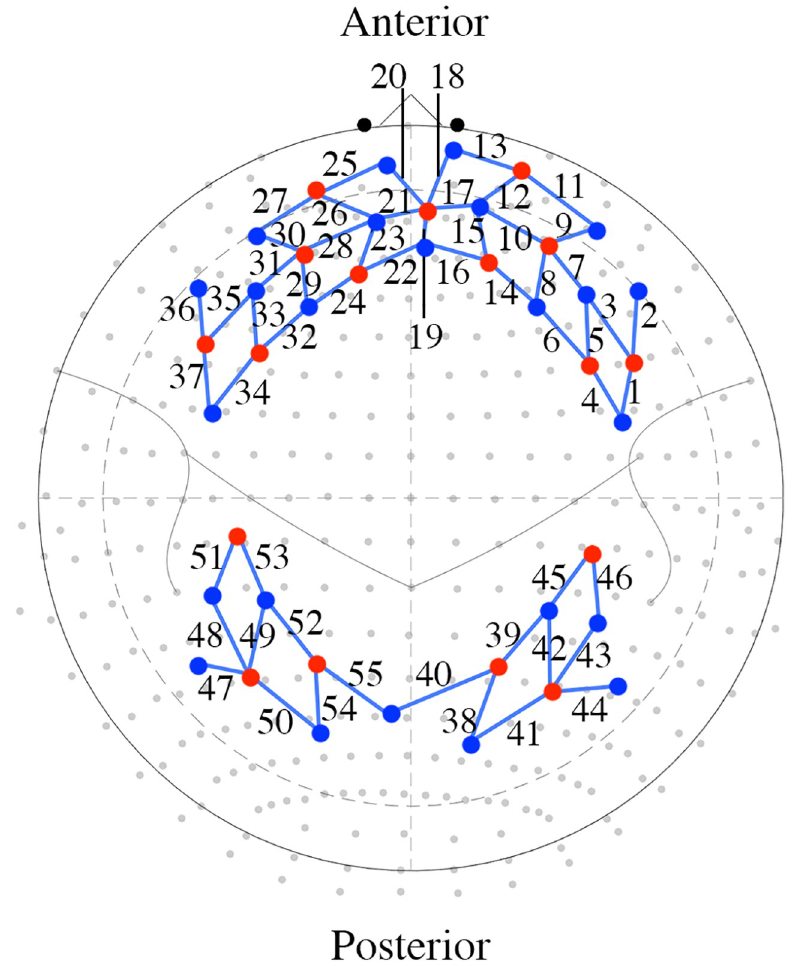
Fig 2. fNIRS optode layout. An anterior and posterior view of the optode montage mapped onto a template brain. Red dots denote a channel source and blue dots represent a channel detector. The blue line connecting a source and detector represents a measured channel; each channel is numbered. Note that the labels for channels 18, 19, and 20 are displaced; a straight black line indicates the position of each channel.